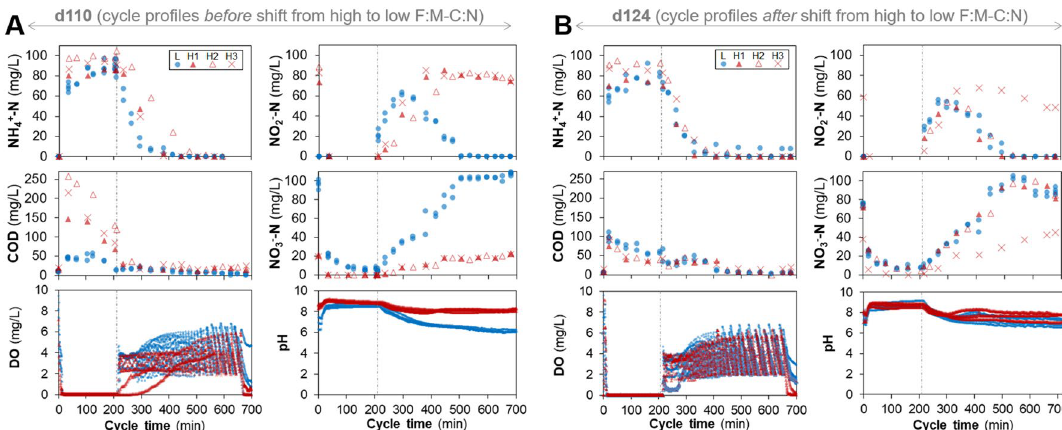
Figure 5. Chemical profiles during a full intermittently-aerated SBR cycle lasting 12 h. Concentrations are shown for all reactors on ( A ) day 110 and ( B ) day 124, showing profiles before and after high to low F:M–C:N changes. L, low F:M–C:N reactors (n = 4); H, high F:M–C:N reactors (n = 3). Vertical dashed dotted line indicates the start of the aerobic stage in each cycle. Right panels ( B ) show that two (H1 and H2) out of three reactors fully recovered the nitrite oxidation function on d124.